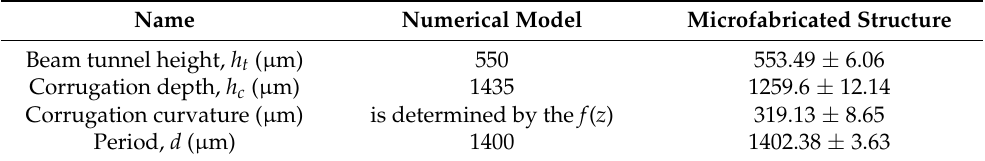
Figure 4. Results of the morphology studies: ( a ) SEM image of the central part of the final sample of the interaction structure; ( b ) image from the optical inspection microscope of the central part of the fabricated interaction structure. Table 1. Dimensional comparison between the original numerical model and the microfabricated sample.